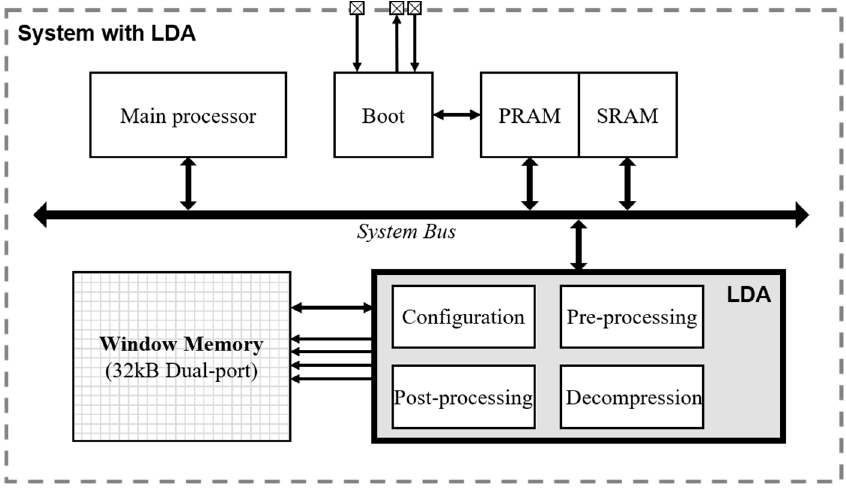
Figure 3. Block diagram of system-on-chip (SoC) with LDA. PRAM, phase-change random access memory: SRAM, static-random-access-memory modules.